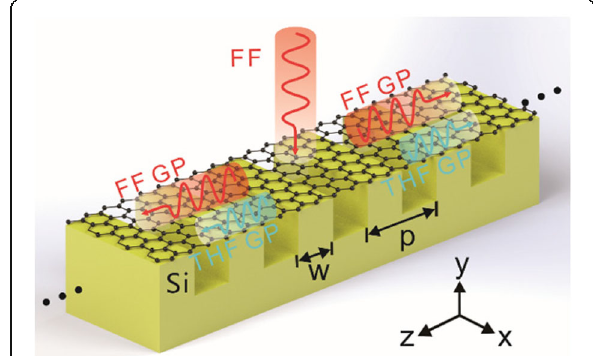
Fig. 1 The scheme of the GSSDG as a THG wavelength converter. The FF GPs (red curves) are excited with a normal-incidence x- polarized plane wave of FF and then generate the THF GPs (blue curves) due to the silicon gratings underneath the graphene sheets. The period of the grating is p , and w denotes the width of